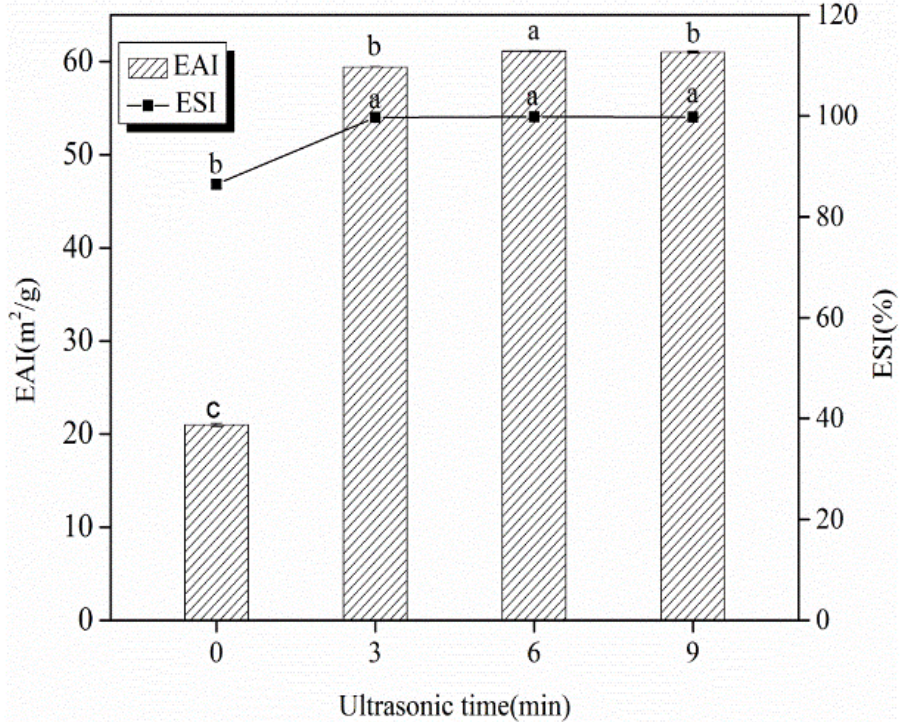
Figure 4. Changes in emulsifying properties of SC-coated O/W emulsions as a result of the high- intensity ultrasound treatment. Different letters above standard deviation bars are significantly different ( p < 0.05).